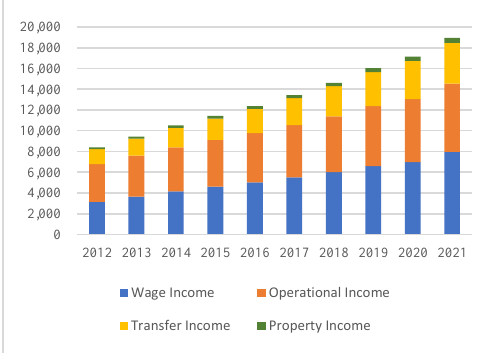
Figure 2. Income composition of rural residents 3 .